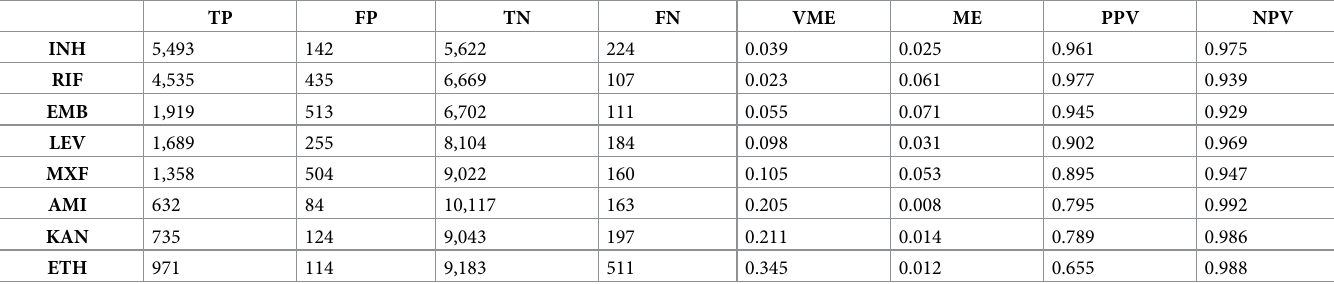
Table 2. Predicting phenotypic resistance using